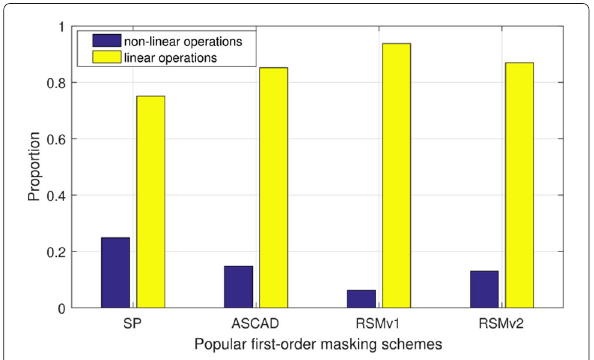
Fig. 1 Running time proportion of non-linear and linear operations in AES first-order masking